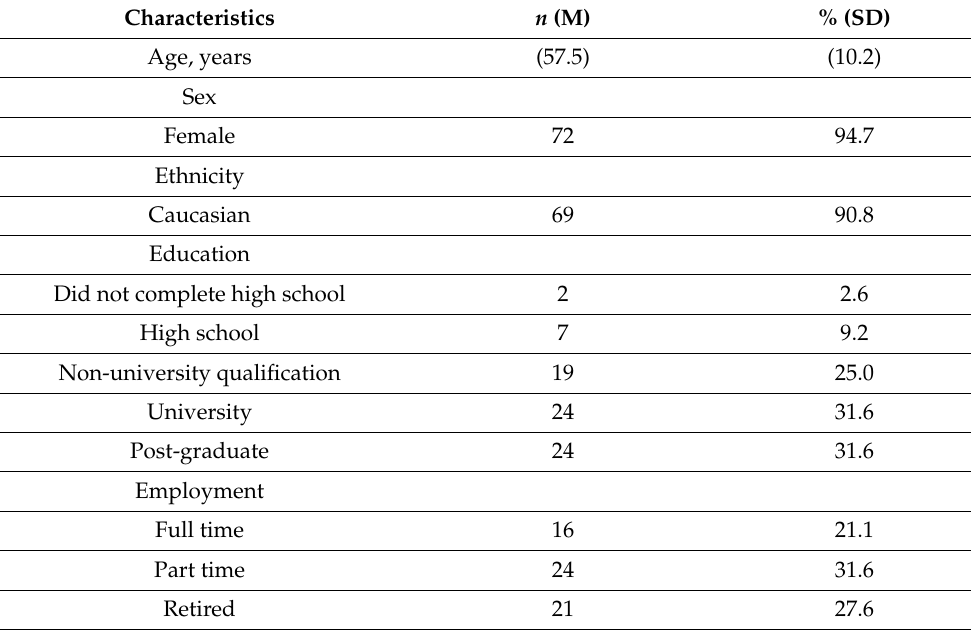
Figure 1. CONSORT diagram of participant recruitment. Note: Tx = treatment; Dx = diagnosis. Table 1. Demographics details of final sample ( n = 76).